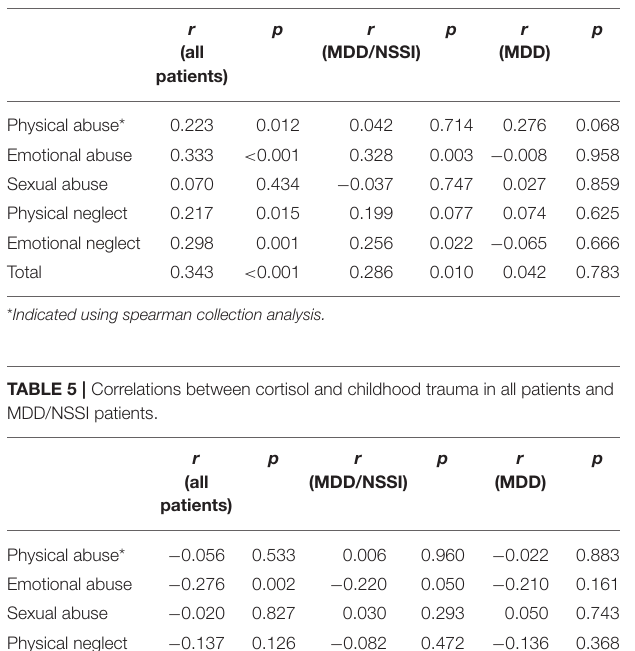
TABLE 4 | Correlations between BDI and childhood trauma in all patients and MDD/NSSI patients.